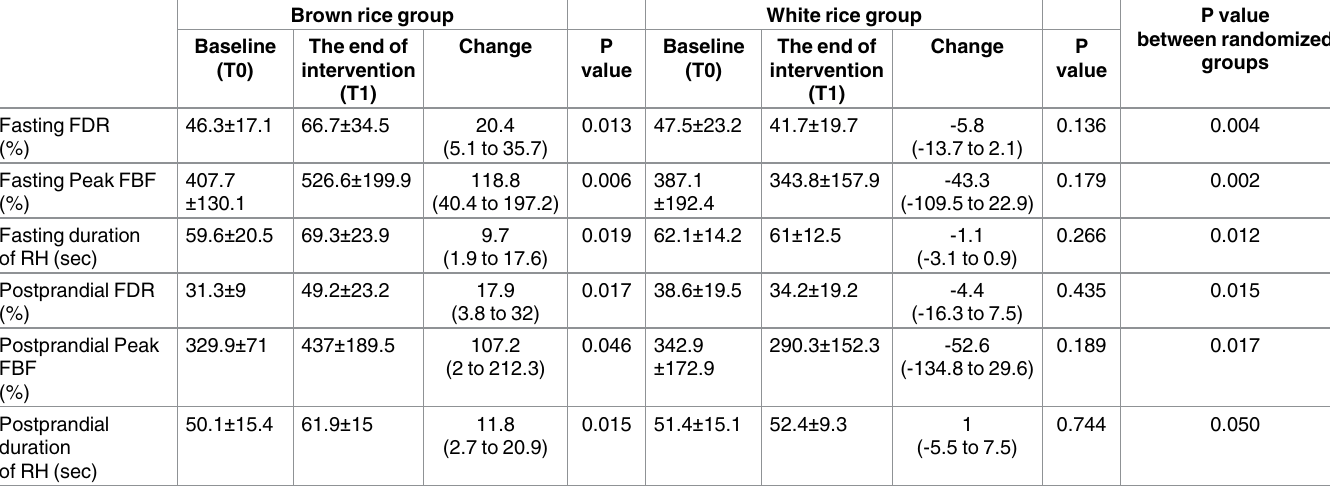
Table 4. Changes in endothelial function in the brown rice and white rice diet groups.